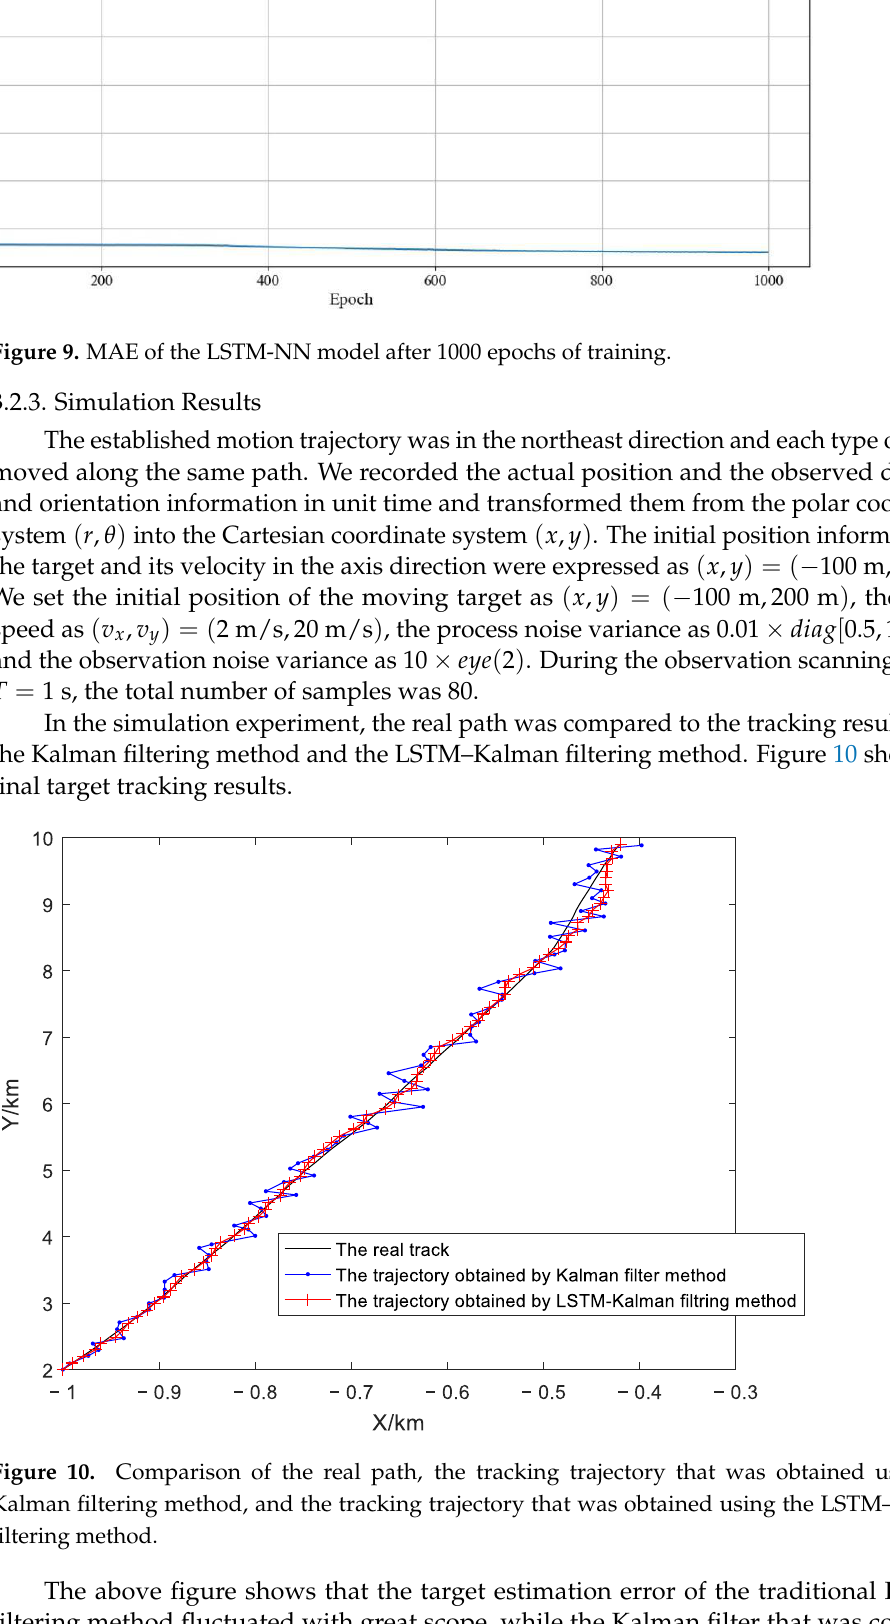
Figure 11. Comparison diagram of the target tracking deviations between the Kalman filtering method and the LSTM–Kalman filtering method. Compared to the actual target trajectory, the traditional Kalman filter deviated by less than 50 m, but the fluctuation range was large and the average deviation was 19.58 m. After the Kalman filtering method was corrected using the LSTM model, the deviation was less than 20 m, the average deviation was 7.79 m, and the overall error was reduced by 60%.